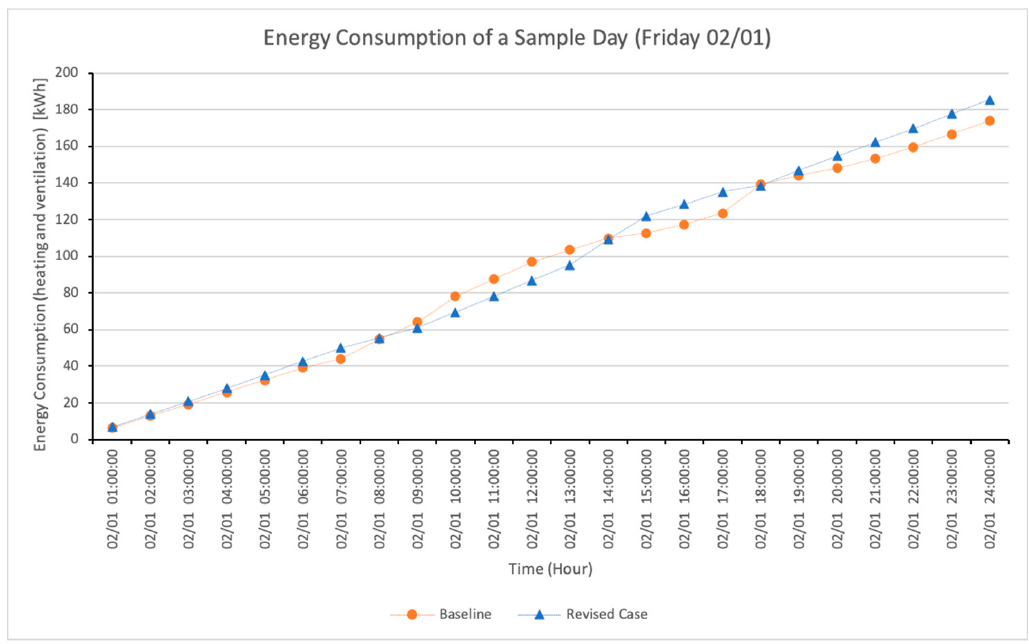
Figure 13. Cumulative Energy Consumption (Mechanical Ventilation and Heating inclusive) of a day, comparison between baseline and revised case.